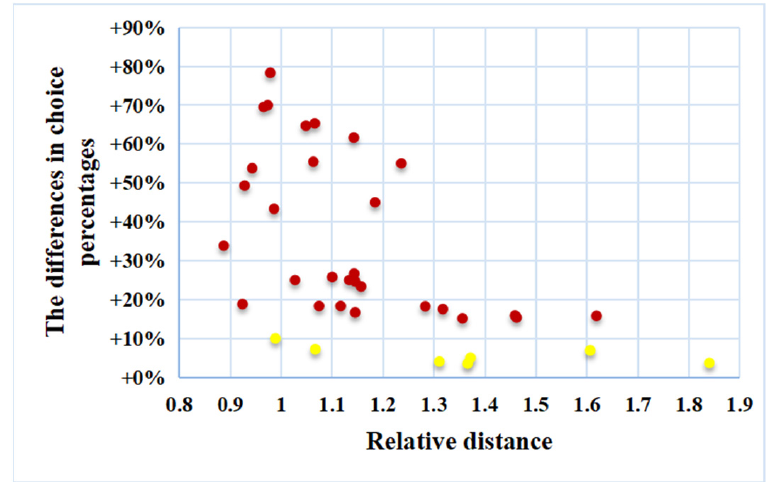
Figure 9. Differences in the choice percentages of the recommended routes with different relative distances.